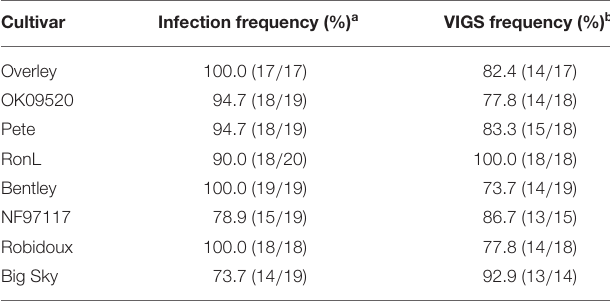
TABLE 2 | BMV:TaPDS 100 -induced TaPDS silencing in eight wheat cultivars.